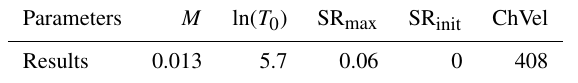
Table 2. The calibrated parameters of TOPMODEL. Parameters M ln( T 0